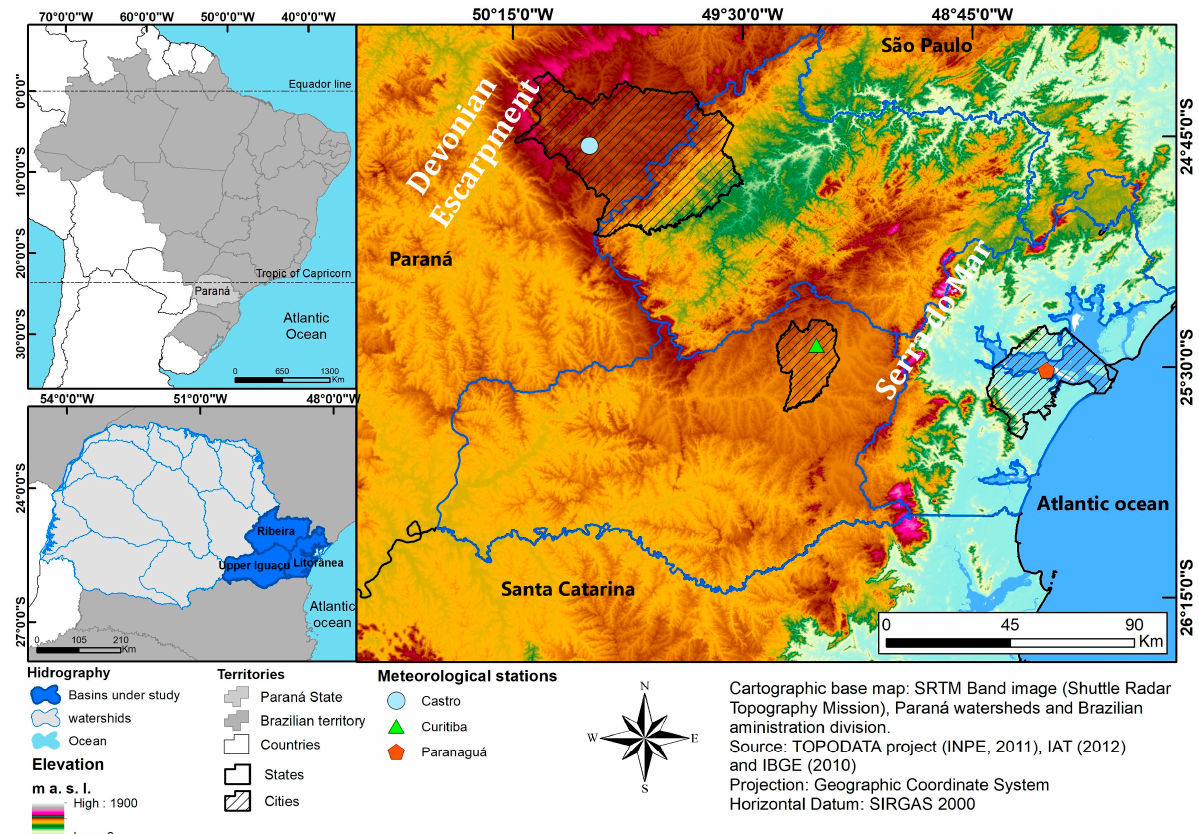
Figure 1. Location of the study area.